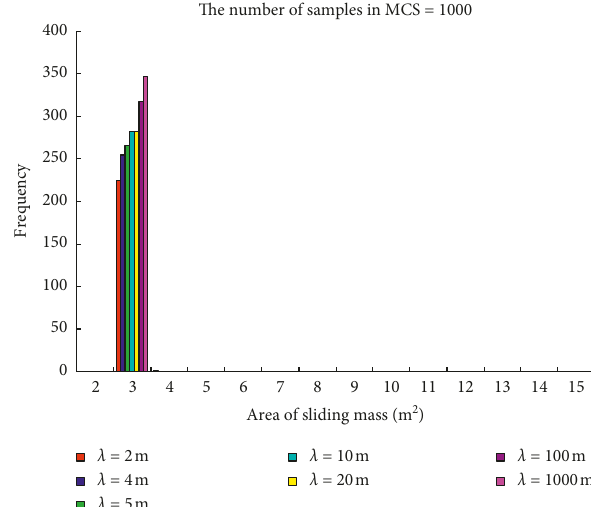
Figure 7: Histogram of area of sliding mass by conventional method.